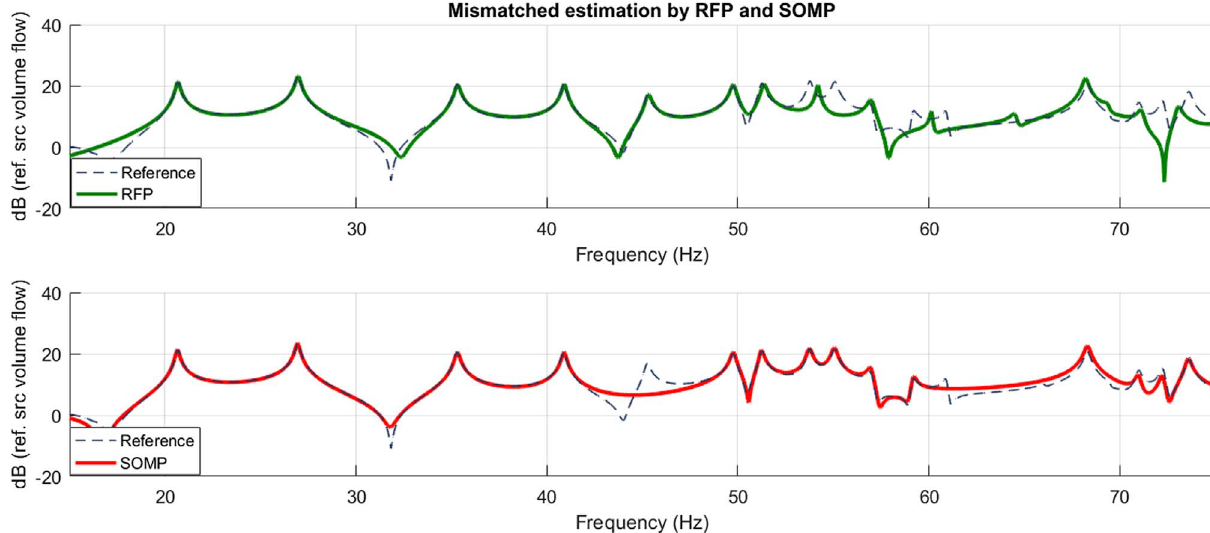
Figure 5. Comparison between the RFRs interpolated with RFP (top) and with SOMP (bottom), when underestimating the number of modes, at a given virtual microphone position. The black curve represents the reference given by FEM